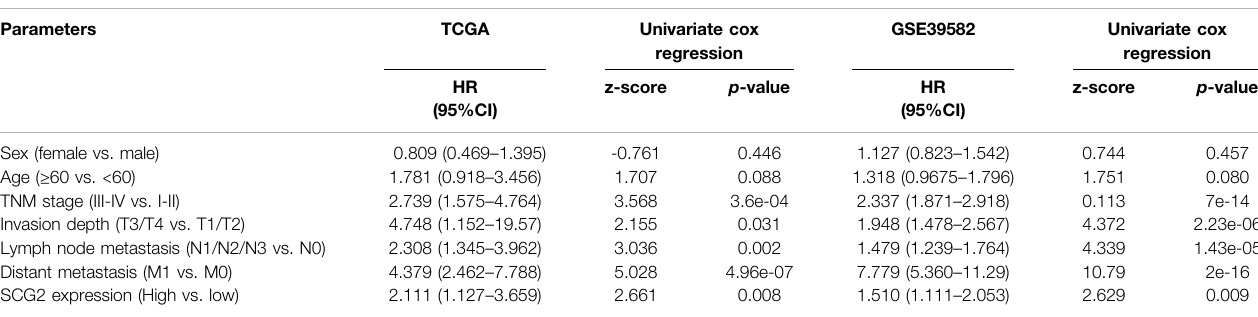
TABLE 1 | Univariate Cox regression of prognostic factors in CRC patients. Parameters TCGA Univariate cox